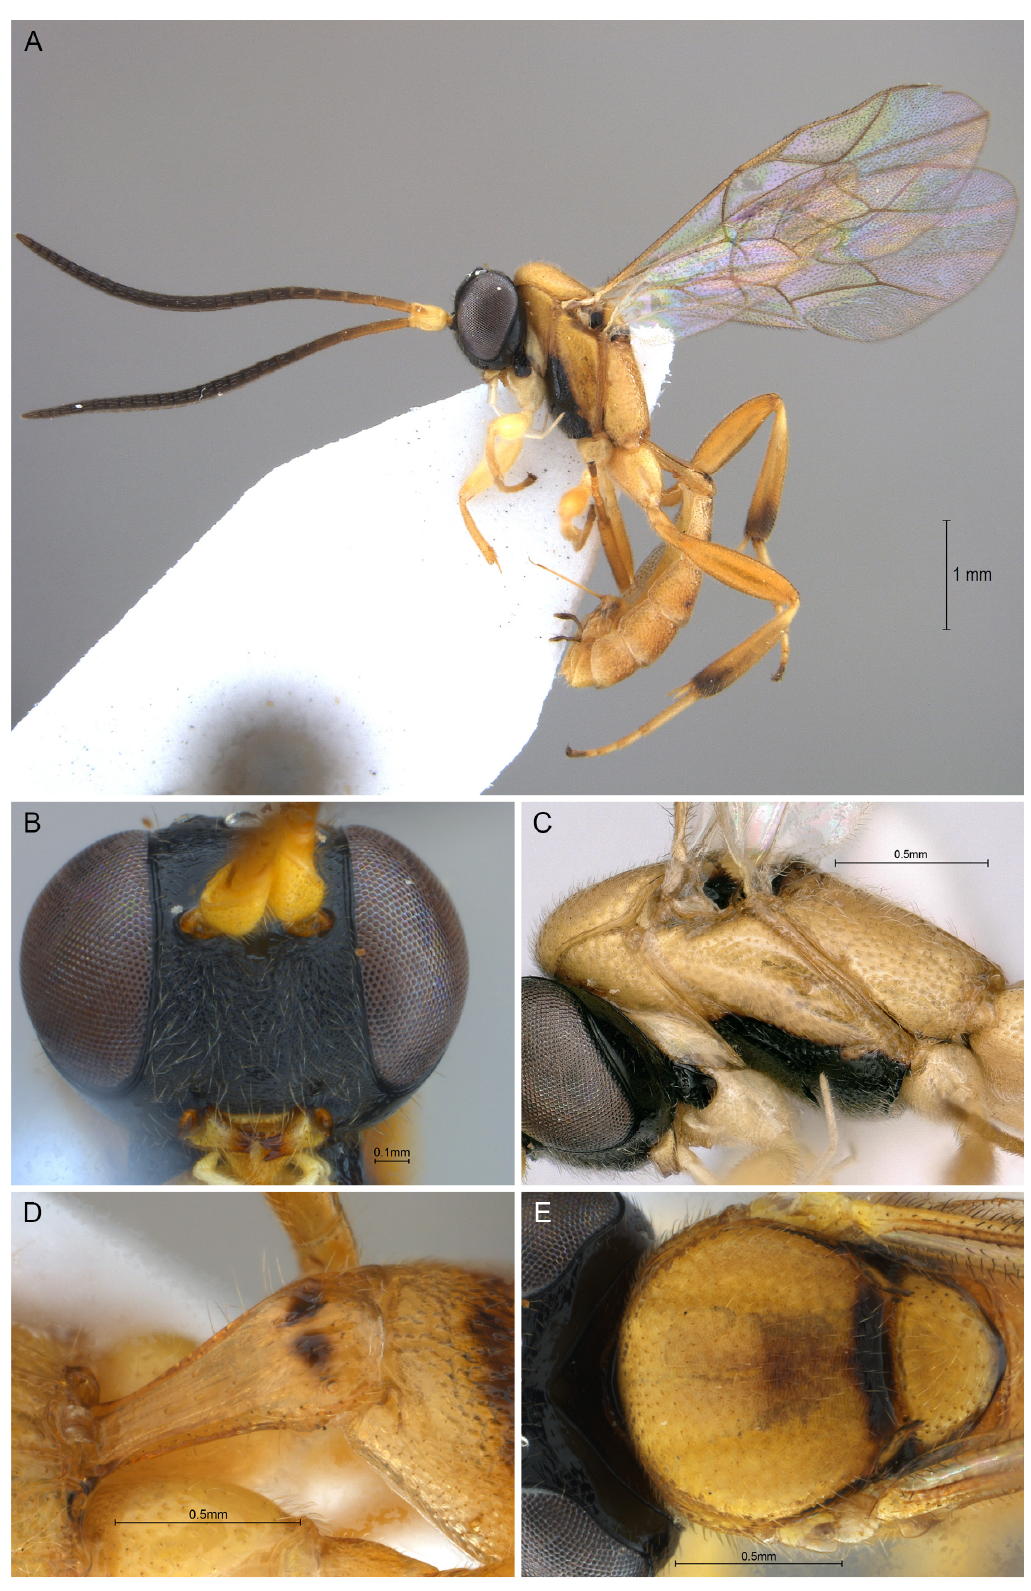
Fig. 9. Palpostilpnus hainanensis sp. nov., holotype, ♀ (SCAU). A . Lateral habitus. B . Head, anterior view. C . Mesopleuron. D . T1, dorsolateral view. E .